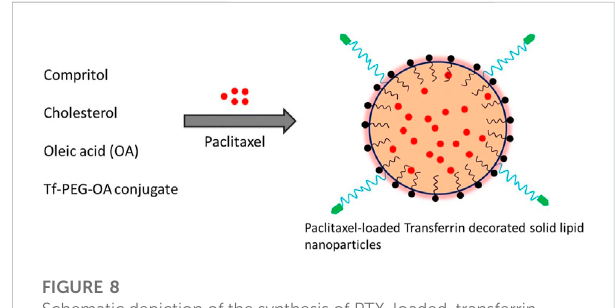
FIGURE 8 Schematic depiction of the synthesis of PTX-loaded, transferrin- coated SLNs (Dai et al.,